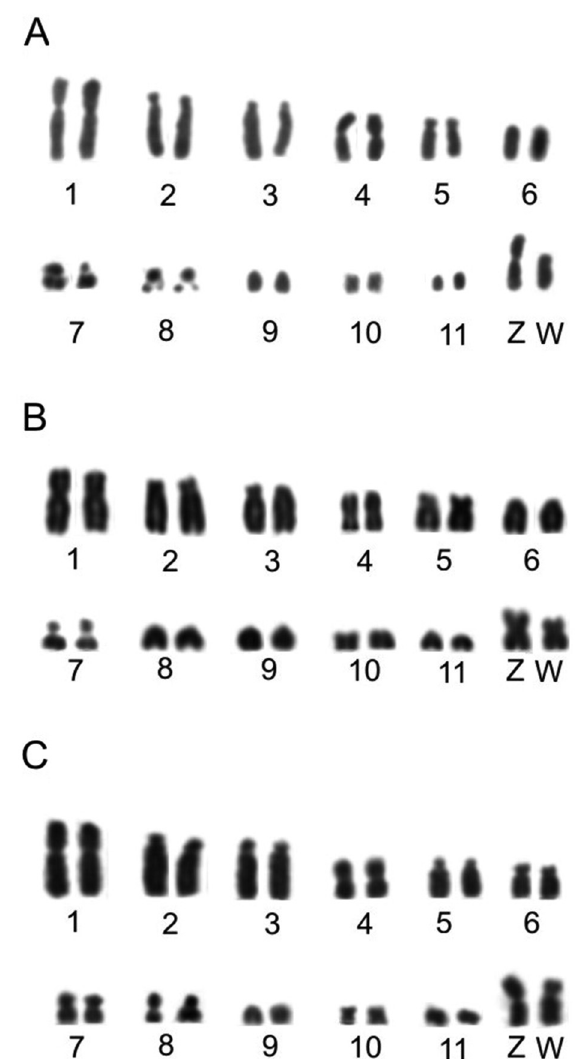
Figure 1 - Partial karyotype of three females with conventional staining (Giemsa). A= P. tapera , B= P. chalybea and C= P.